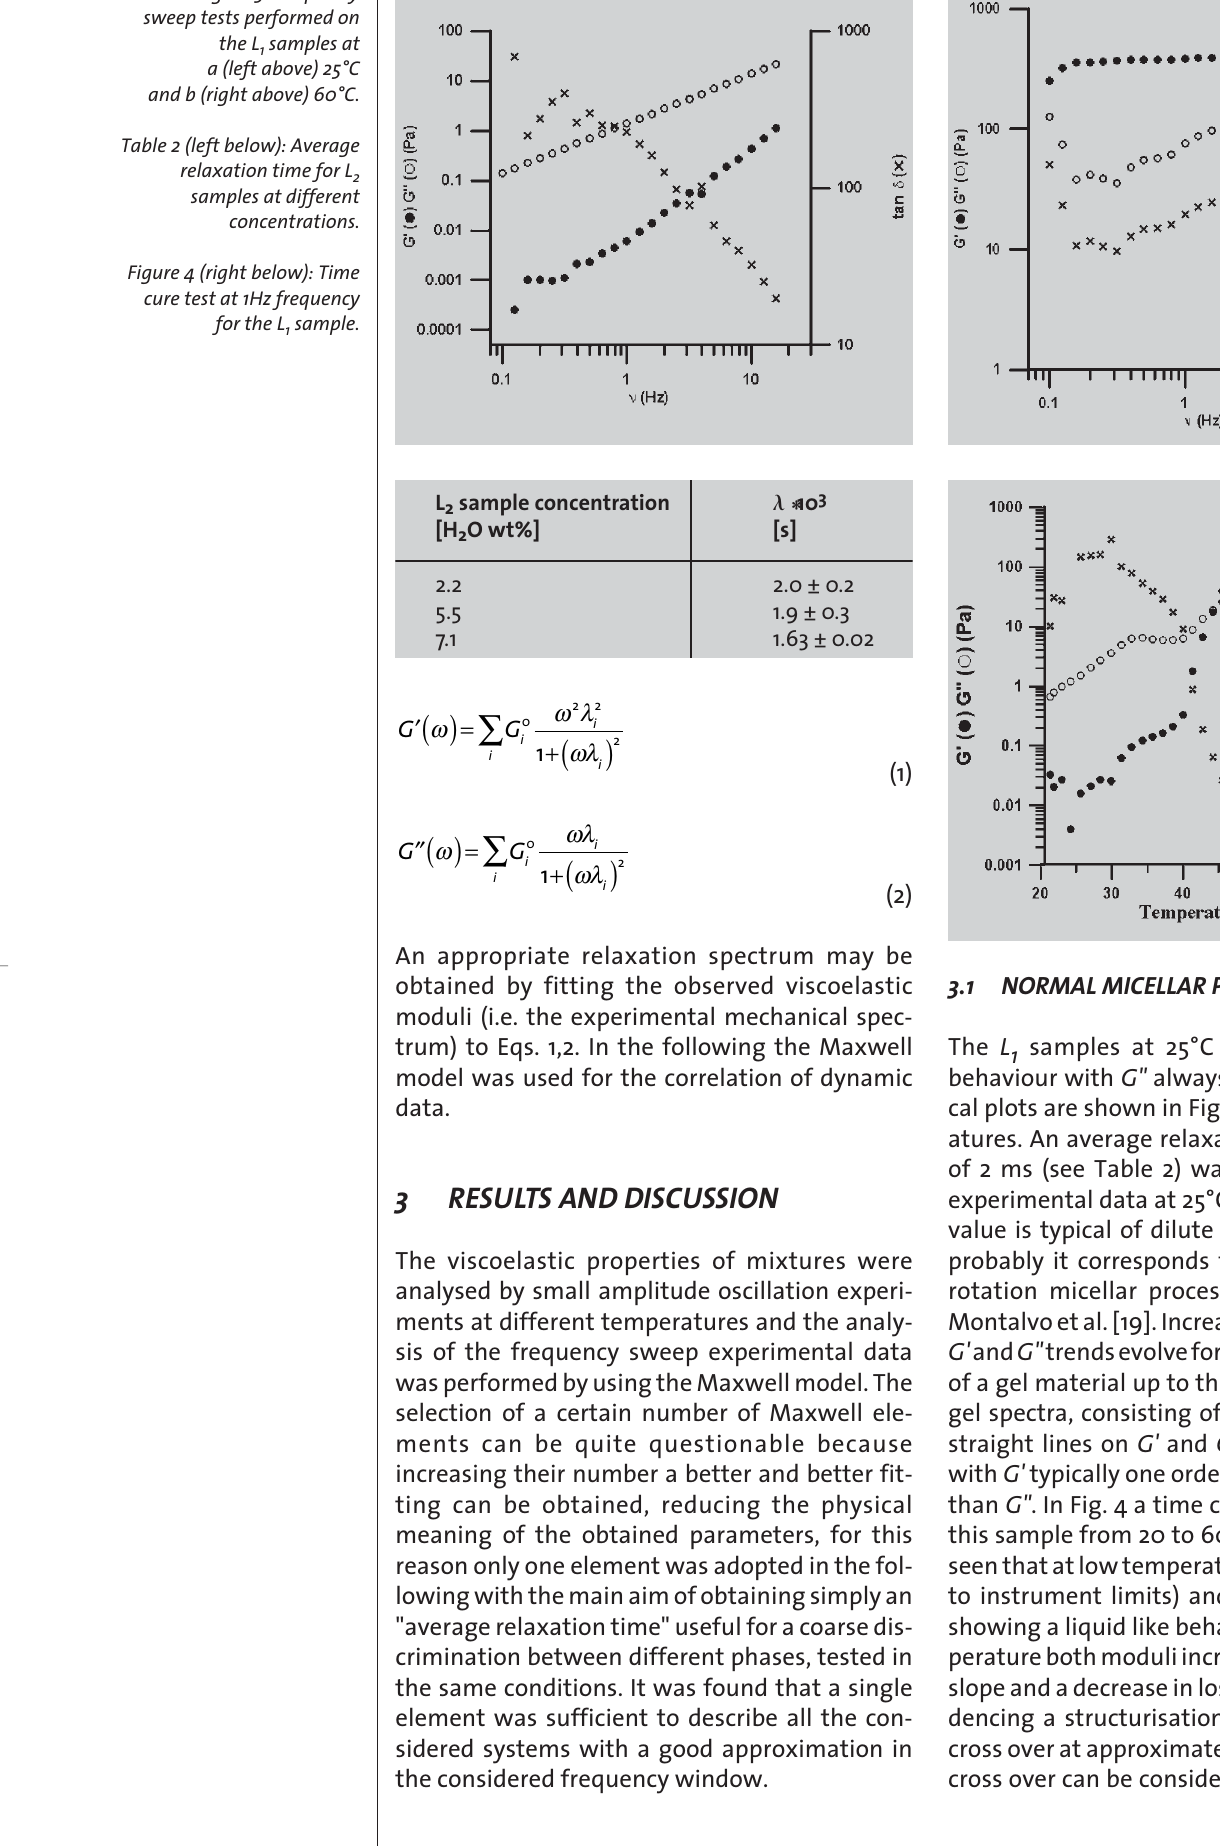
Figure 3: Frequency sweep tests performed on the L 1 samples at a (left above) 25°C and b (right above) 60°C. Table 2 (left below): Average relaxation time for L 2 samples at different concentrations. Figure 4 (right below): Time cure test at 1Hz frequency for the L 1